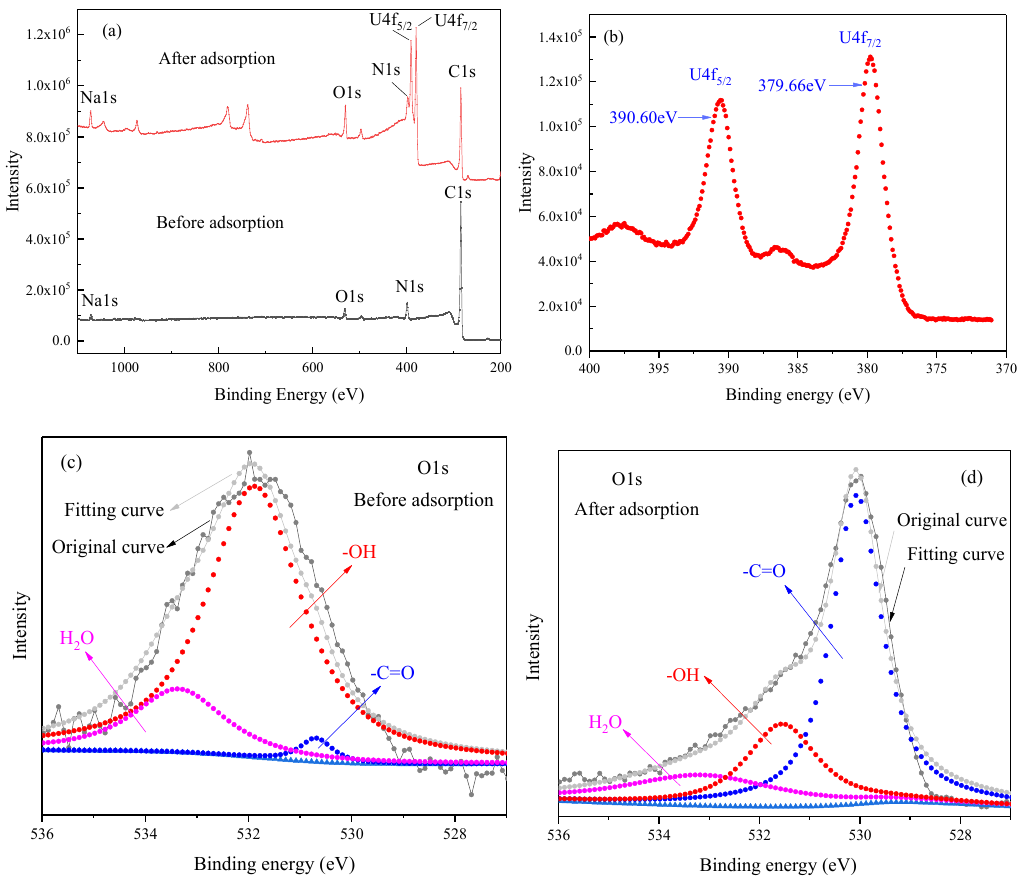
Figure 10. ( a ) XPS spectra of the CMC/P (NIPAM-co-AA) hydrogel before and after U(VI) adsorption, ( b ) high-resolution XPS spectra of U4f, and ( c , d ) O1s before and after adsorption.